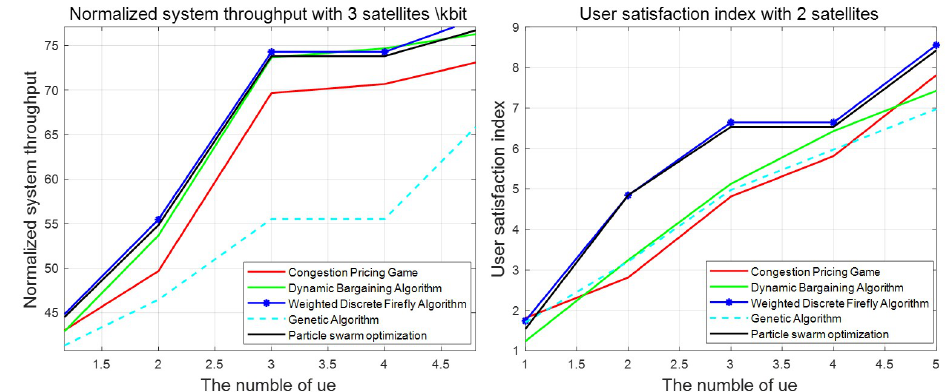
Figure 12. The normalized system throughput of the different number of users with the different number of satellites using different